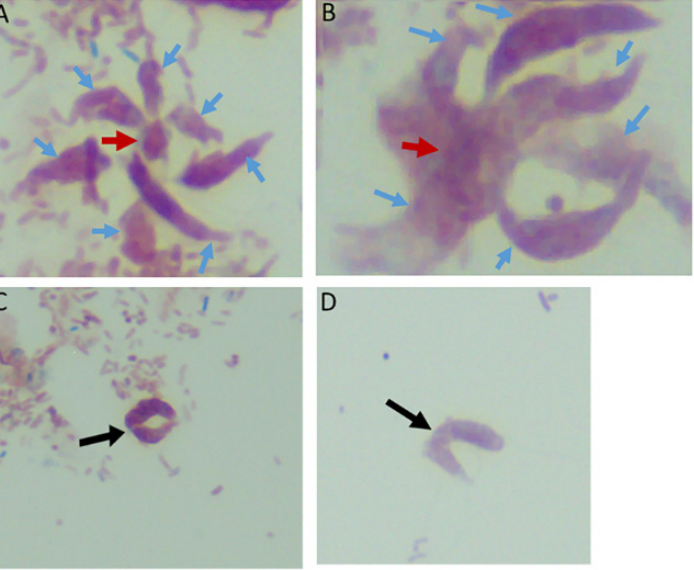
Figure 2. Multiple Colpodella sp. (ATCC 50594) trophozoites (blue arrows) feeding on a single P. caudatus prey (red arrowhead) in panels ( A , B ). Paired juveniles still attached after egress from the cyst were observed with point of attachment shown by the black arrow in panels ( C , D ).